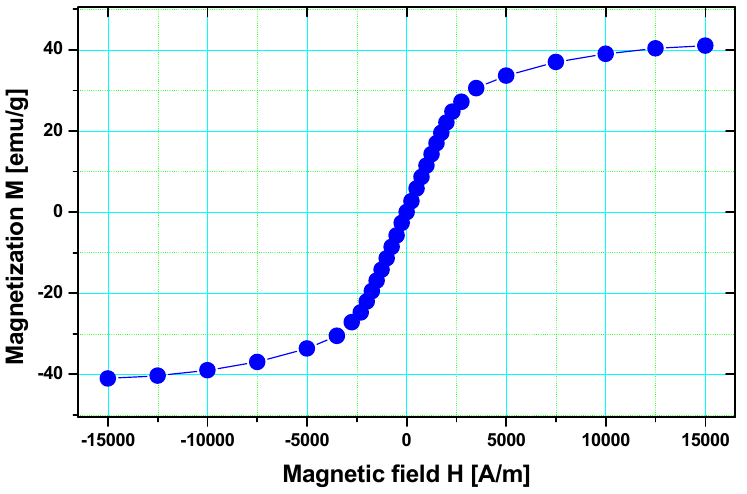
Figure 4. Magnetization curve of fluidMAG − OS magnetite nanoparticles; full symbols represent the experimental results, and the line represents the theoretical model.